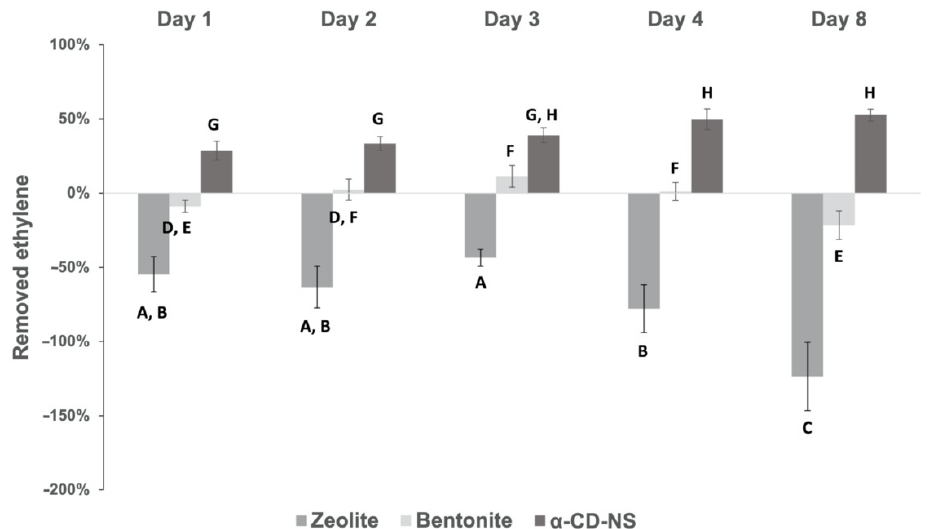
Figure 13. Ethylene removal percentage of α -CD-NS and commercial bentonite and zeolite across time. Mean ± SD of three replicates is shown. Different letters show significant differences ( p ≤ 0.05) between samples.